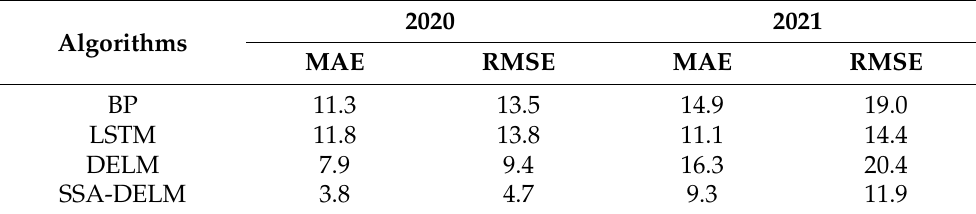
Table 3. Test set error performance on Model C in 2020 and 2021.